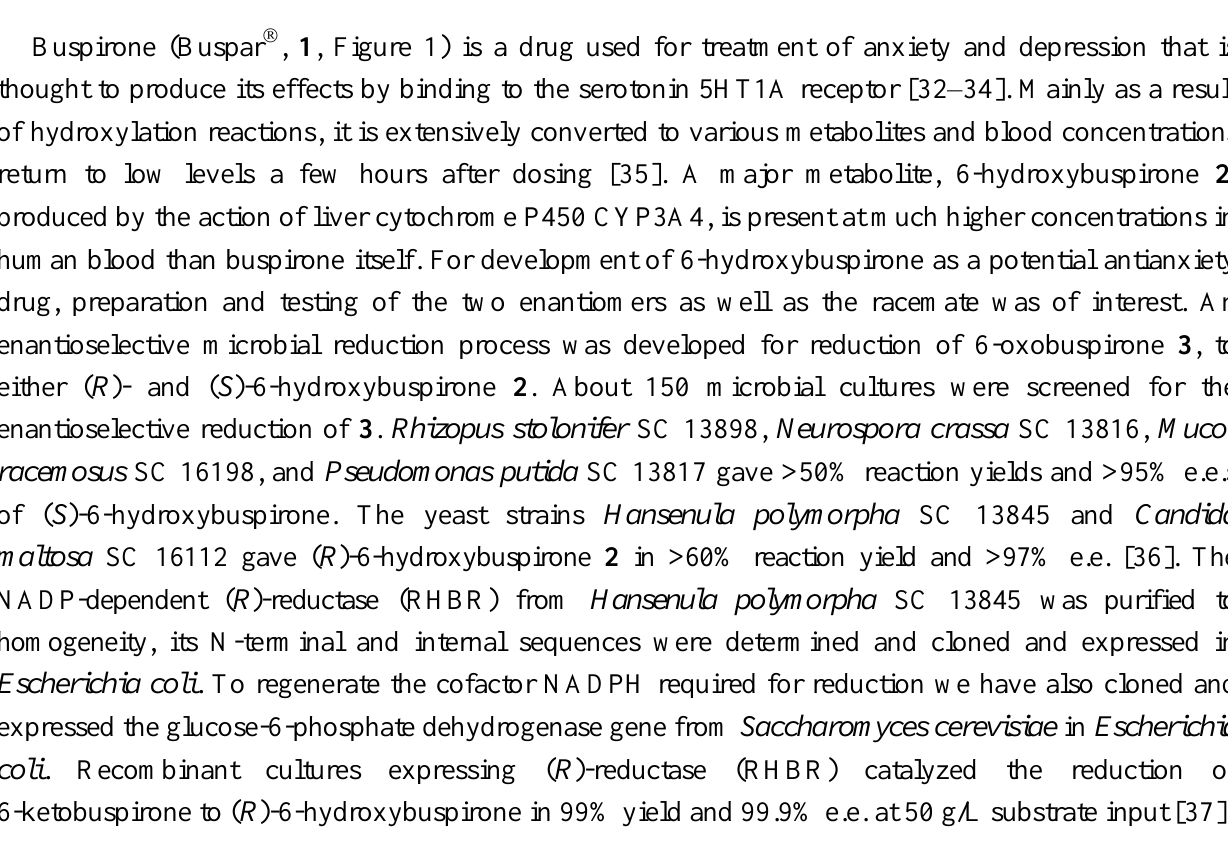
Figure 1. Hydroxy buspirone (antianxiety drug): Enzymatic preparation of